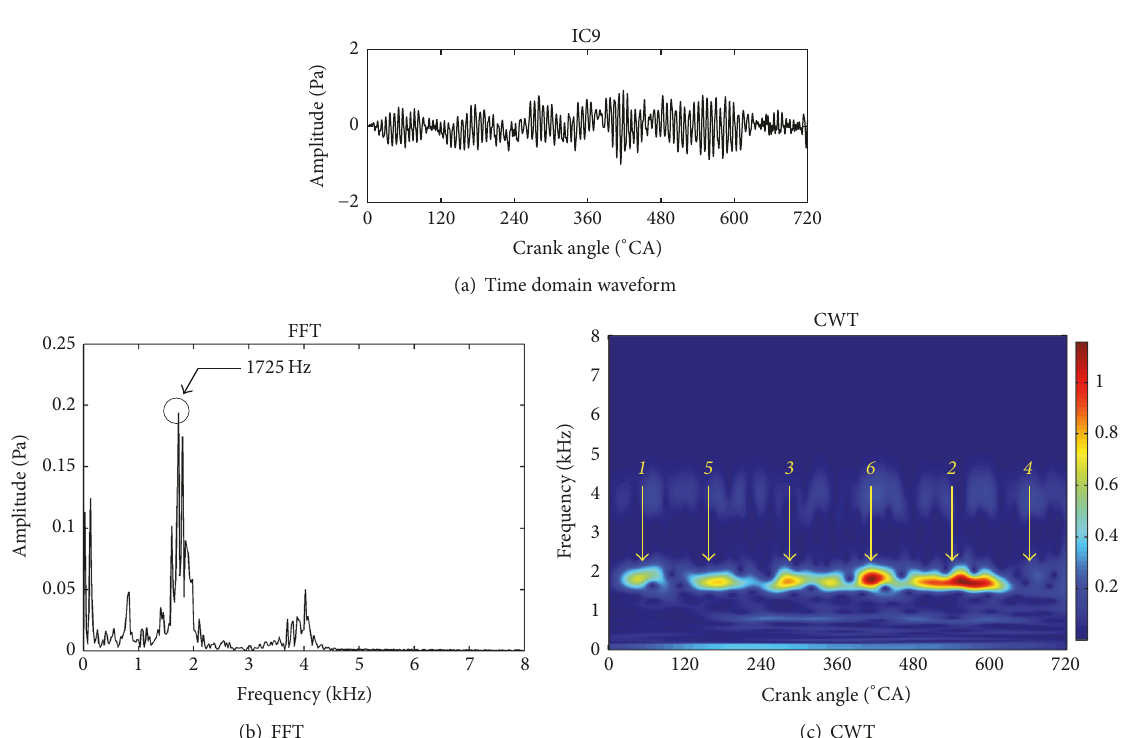
Figure 15: Time domain waveform, FFT, and CWT of IC9 by the Gammatone-RobustICA method.